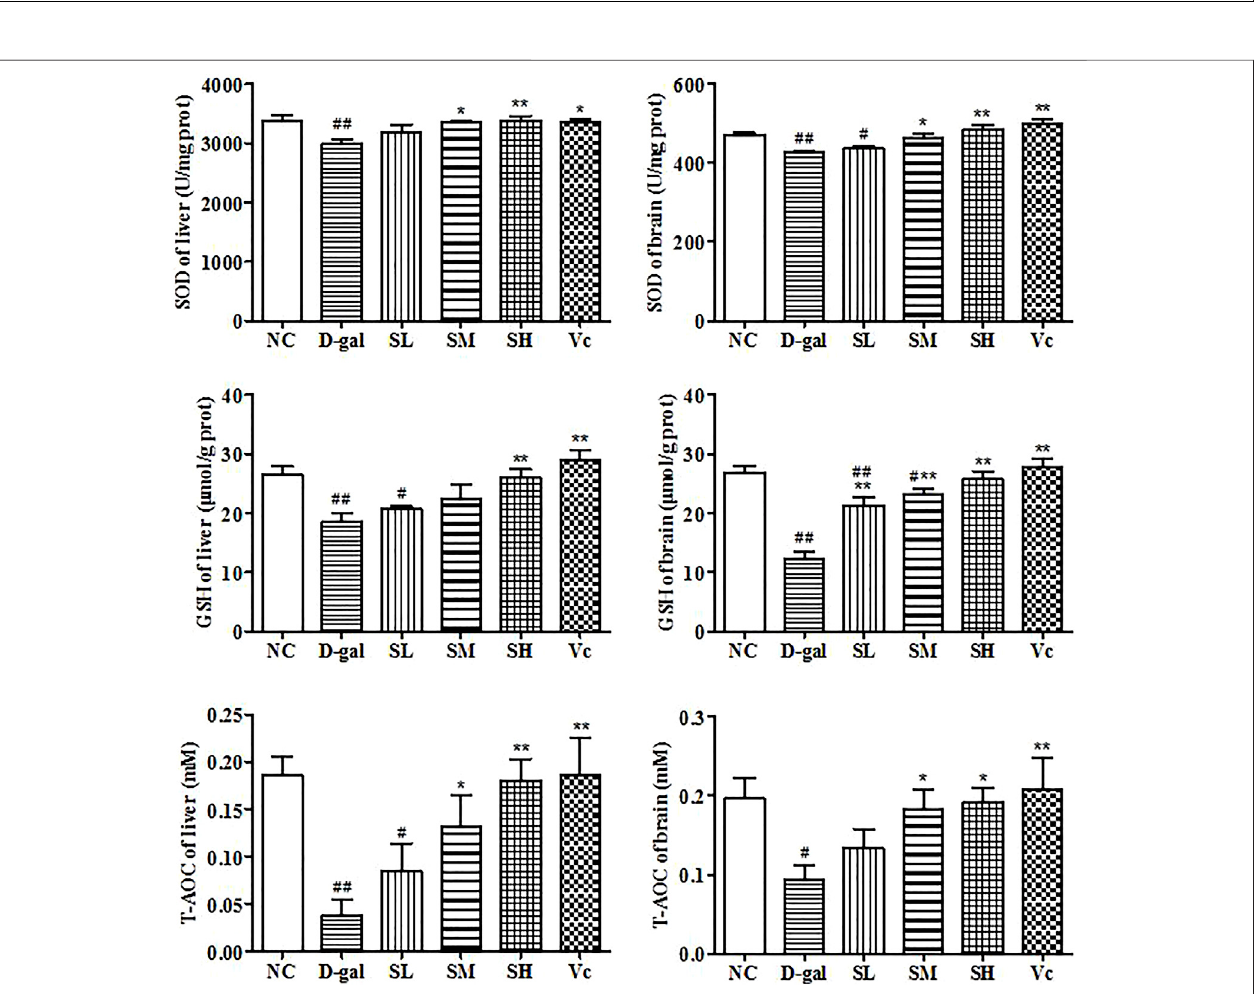
FIGURE 6 | Antioxidant enzyme activity in liver and brain. Compared with normal group, #: p < 0.05, ##: p < 0.01; Compared with D – gal group, *: p < 0.05, **: p < 0.01. NC: normal control group; D – gal: D – gal model group; SL: low – dose SDE group; SM: medium – dose SDE group; SL: high – dose SDE group; Vc: Vc positive control